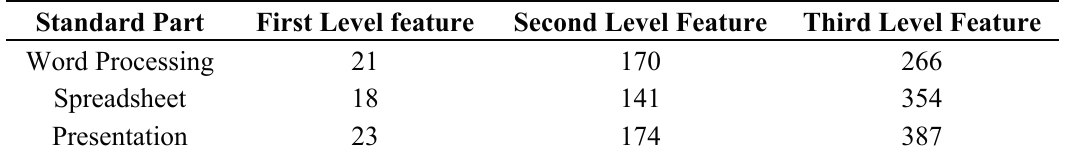
Table 1. Feature Division of Document Format